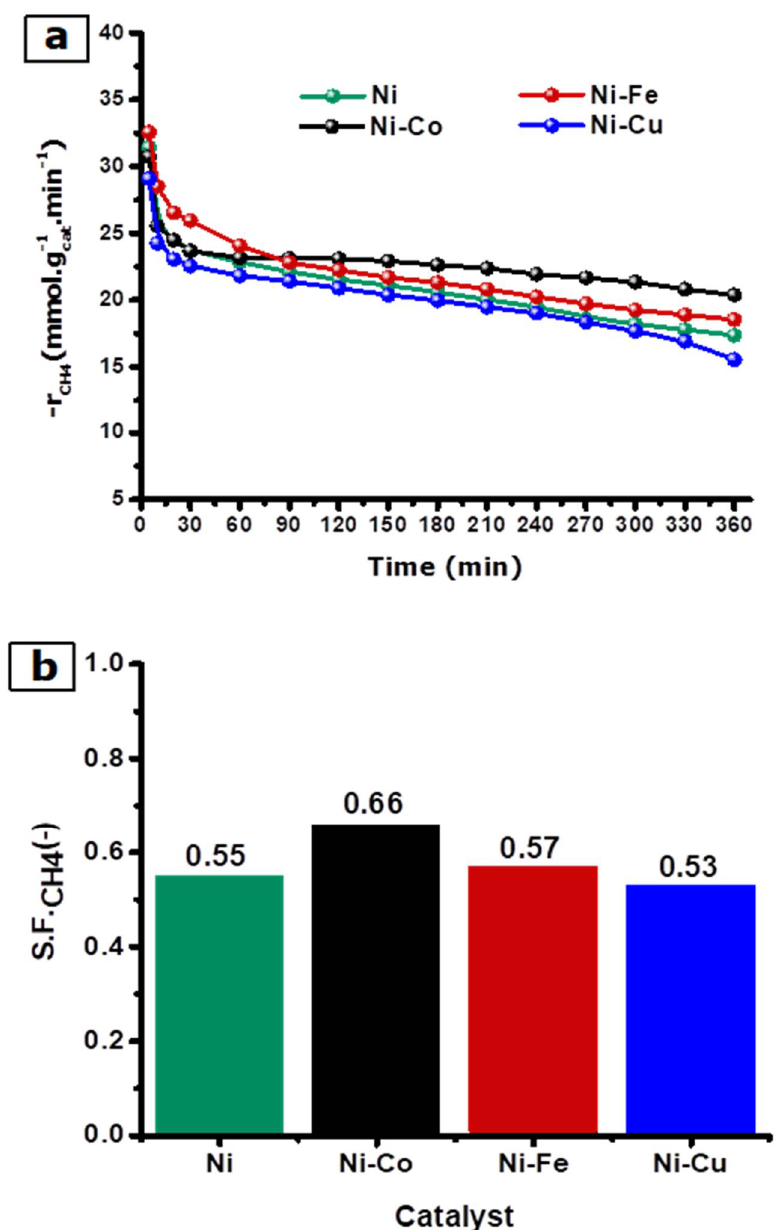
) as a function of TOS and ( b ) sustainability factors ( S . F CH 4